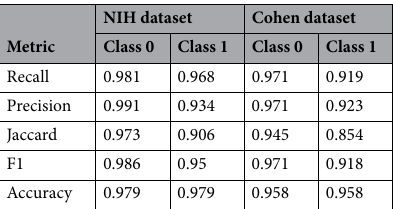
Table 2. Accuracy metrics for lung segmentation from CXR based on U-net applied to two public datasets: NIH 35 and Cohen 17 . class 0 = background, and class 1 = foreground/lung area.